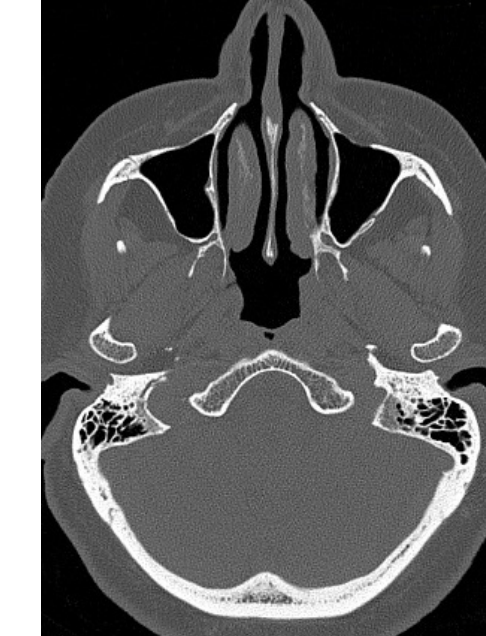
Figure 2. 3D model of the nasal cavity.